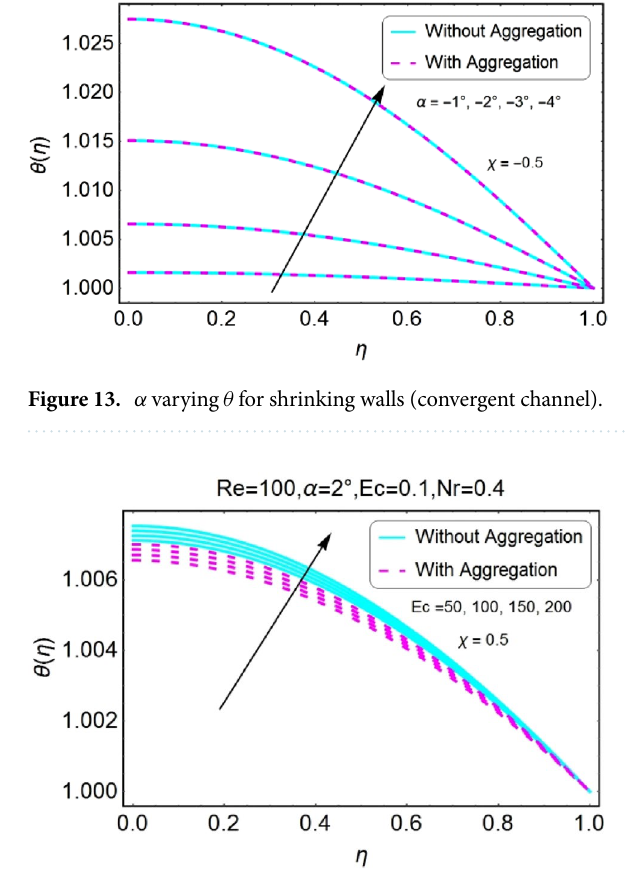
Figure 14. Ec varying θ for stretching walls (divergent channel).